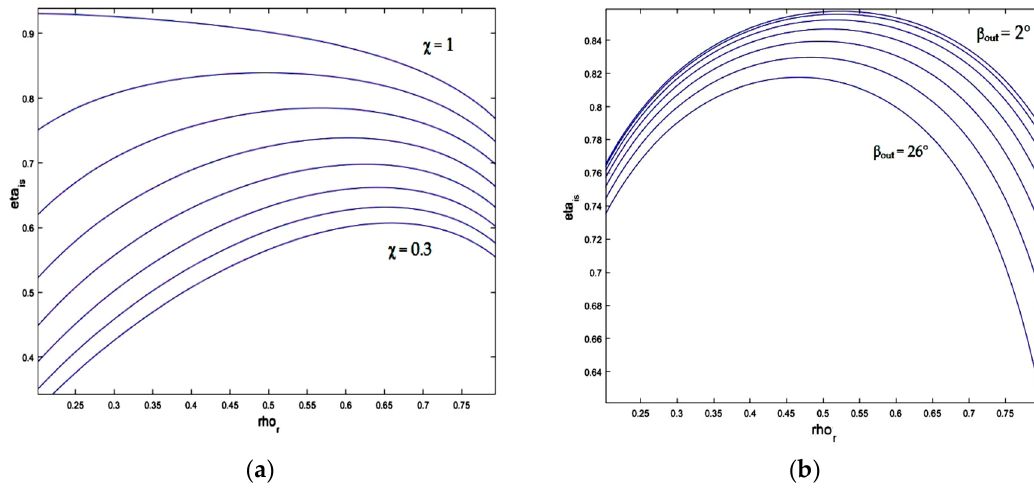
Figure 9. Isentropic efficiency: ( a ) Variation of the isentropic efficiency with ρ r for different β out and fixed χ ; ( b ) Variation of the kinematic efficiency with ρ r for different χ and fixed β out .